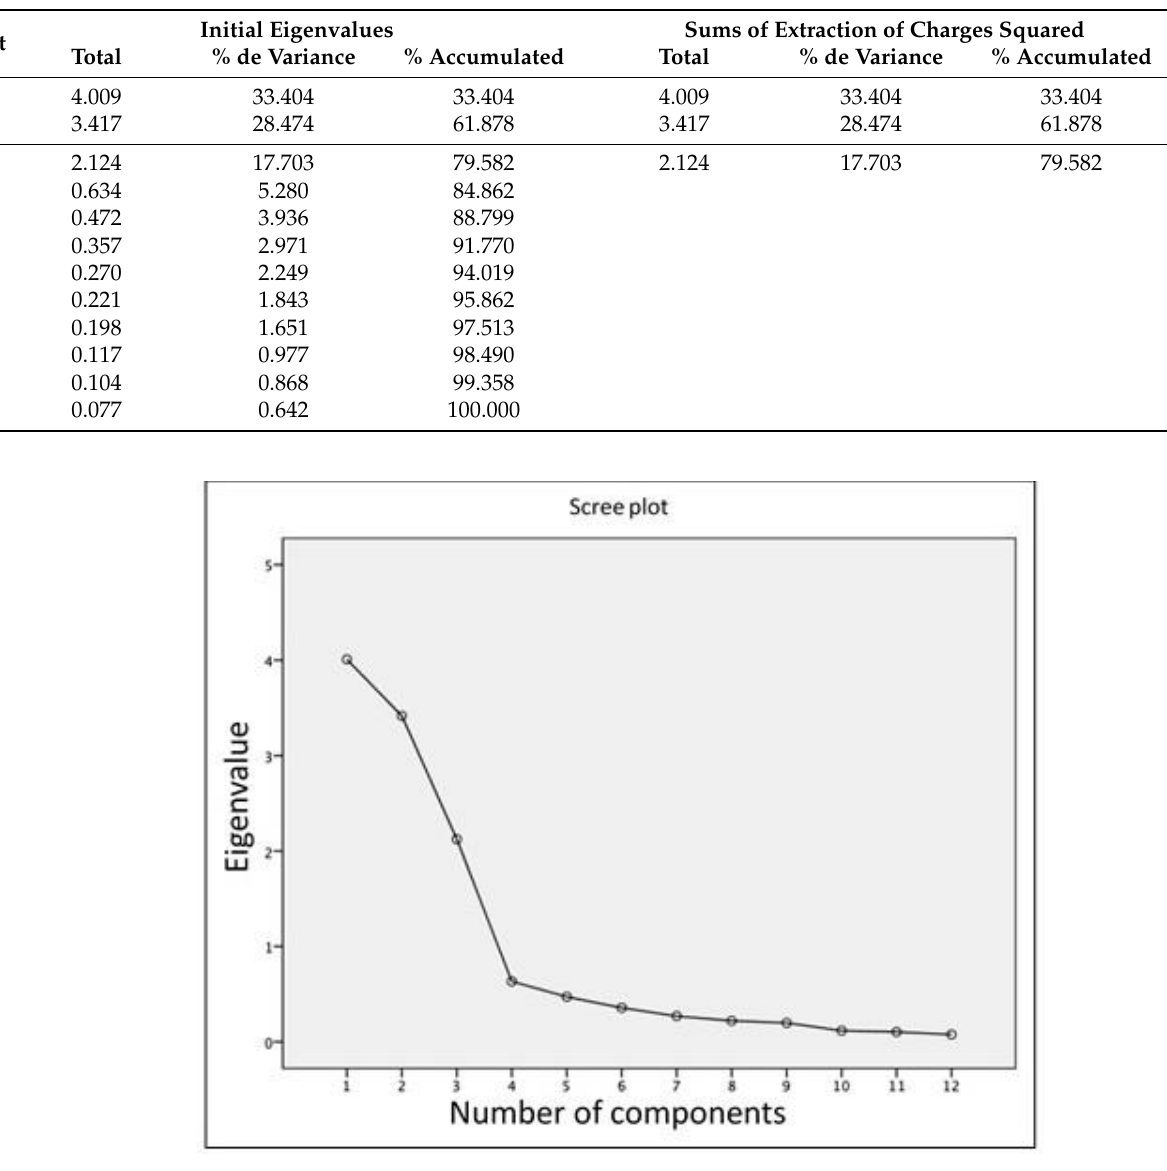
Figure 2. Scree plot of each of the OSTRC-Sp components. Table 3. Results of the explained variance analysis of each of the items in which the OSTRC-Sp is structured.